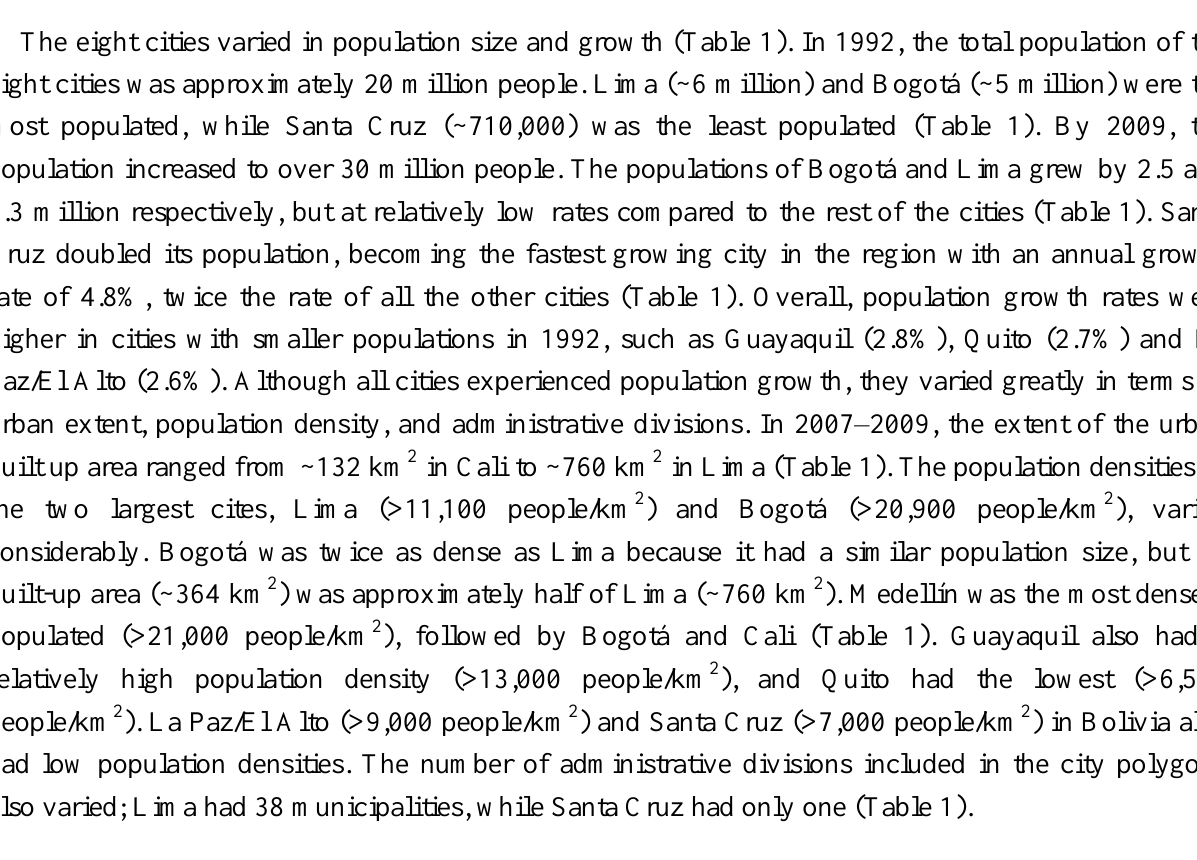
Table 1. Population change from 1992 to 2009, density and urban extent of the eight major cities in the Andean